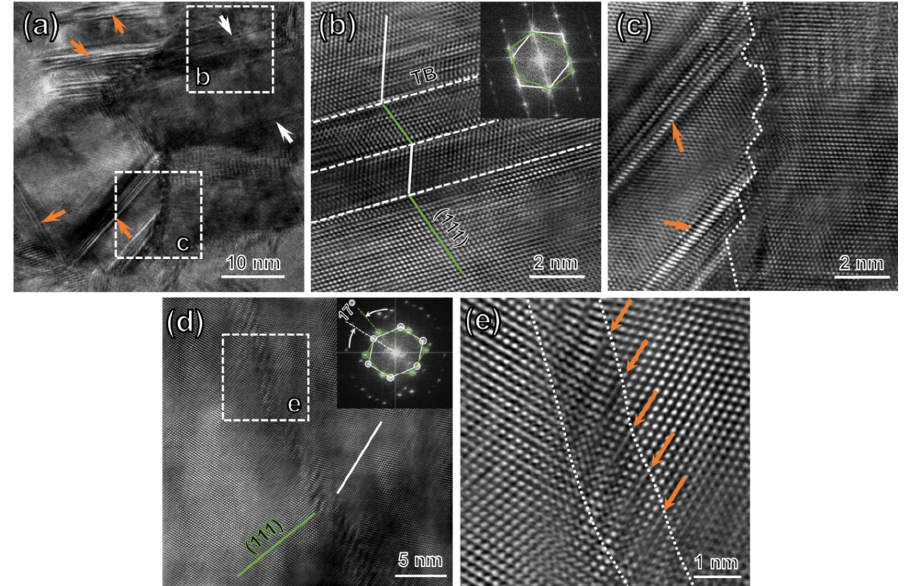
Figure 4. ( a ) HRTEM image of nanograins containing high-density stacking faults (SFs) and nanotwins (as labeled by orange and white arrows, respectively) formed after SMGT. ( b ) An atomic-resolution TEM image of the area b in ( a ) showing the formation of nanotwin structures with an average twin thickness of 2 nm. ( c ) An atomic-resolution TEM image of the area c in ( a ) showing the faceted grain boundary. ( d ) HRTEM image showing the dissociated HAGBs formed between two adjacent nanograins. ( e ) An atomic-resolution TEM image of the area e in ( d ) showing an array of SFs (as labeled by orange arrows) decorated along the dissociated grain boundary. We also observed that grain boundaries associated with nanotwins or SFs became faceted frequently, as shown in Figure 4c, where the steps of (111) planes along the grain boundaries are labeled. A previous study reported that the emission of nanoscale twins